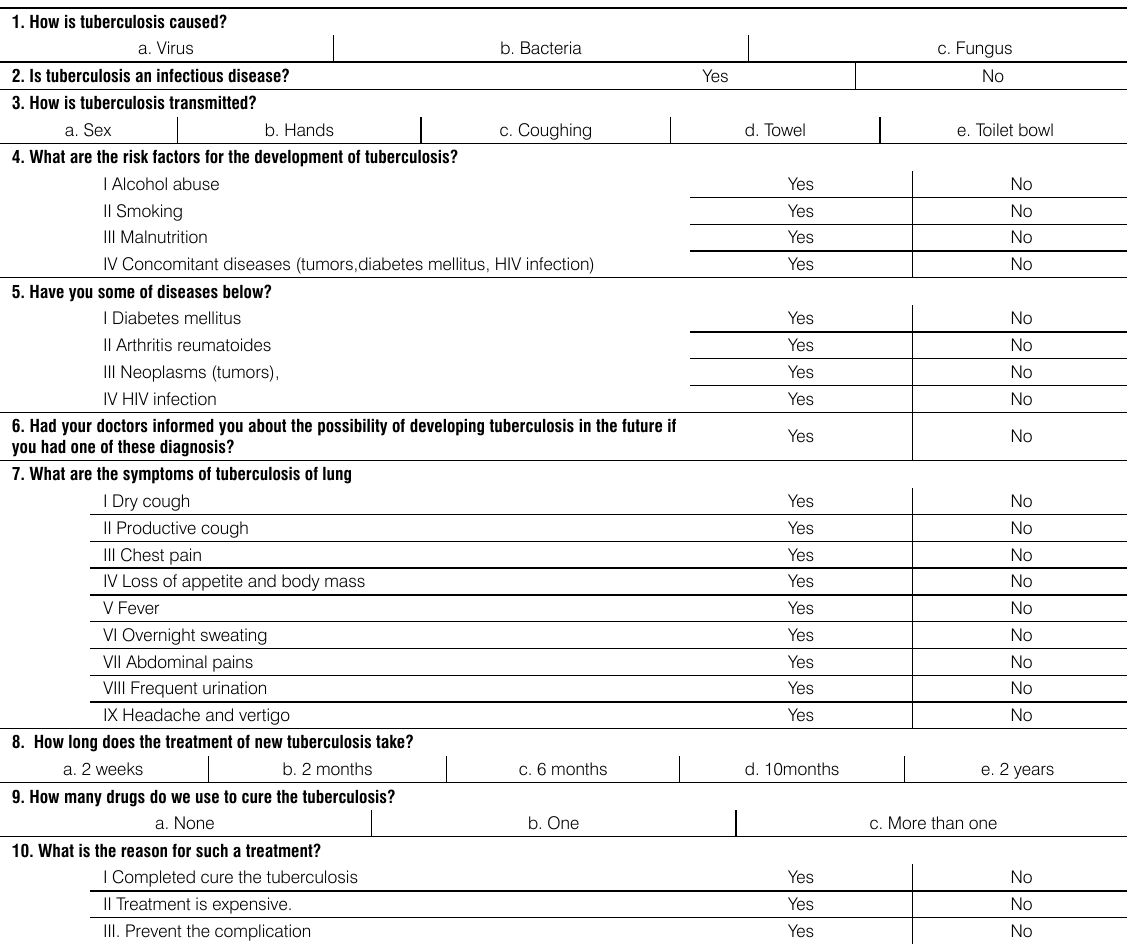
Figure 1. Questionnaire